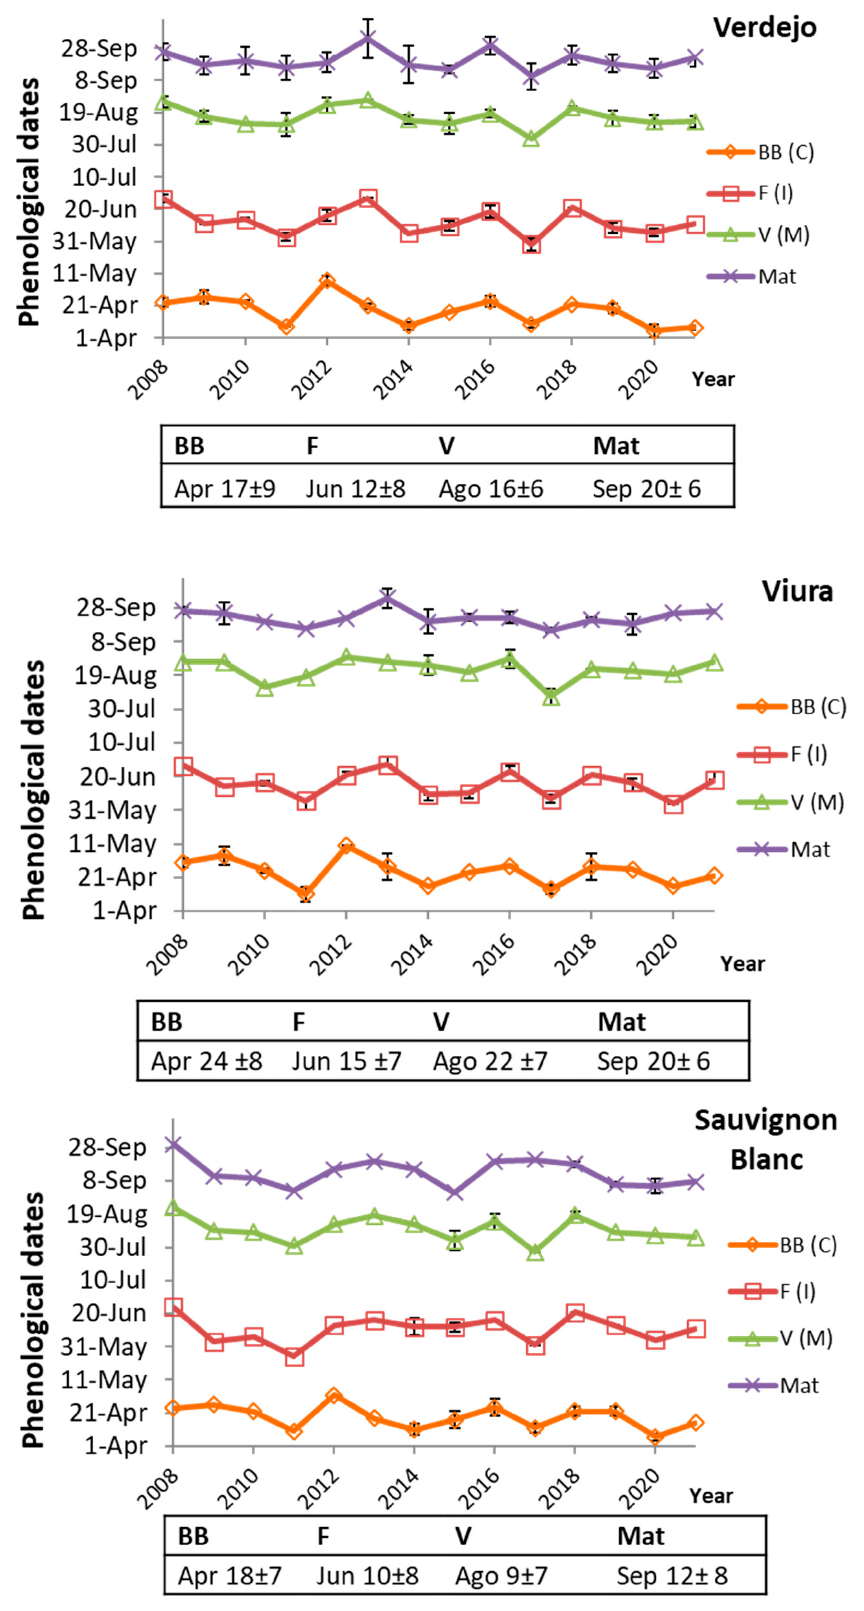
Figure 3. Variability in the phenological timing (stages C, I, M, according to Baillod and Baggiolini [26]) and ripening (harvest date) for the analysed varieties (Verdejo, Viura and Sauvignon Blanc) in Rueda DO, during the period 2008–2021.